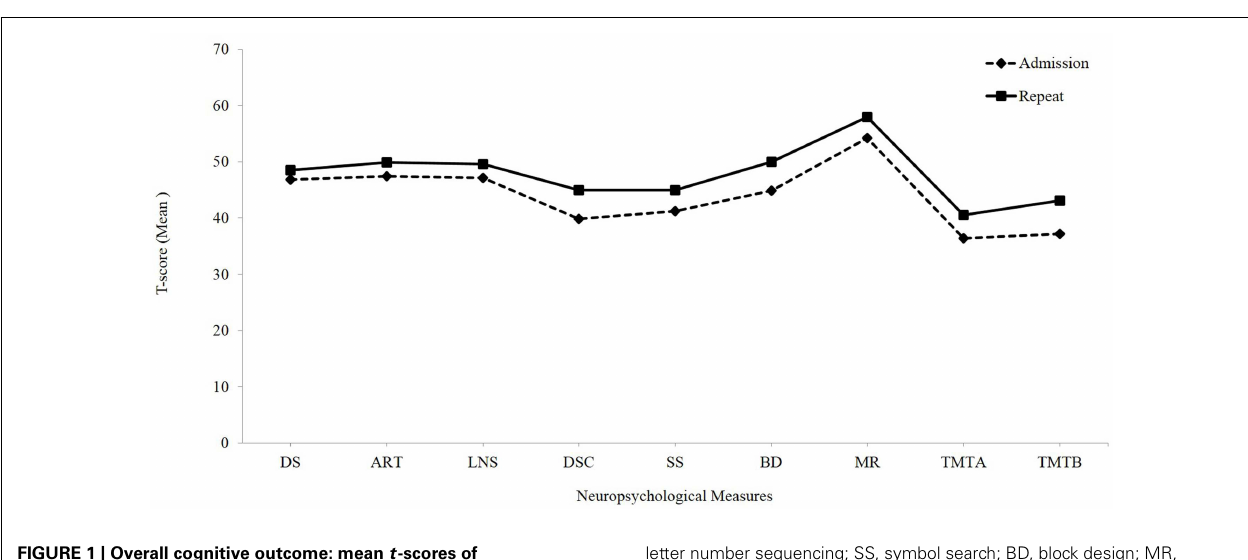
FIGURE 1 | Overall cognitive outcome: mean t -scores of neuropsychological measures at admission and repeat evaluations independent of the driving status . DS, digit span; ART, arithmetic; LNS,